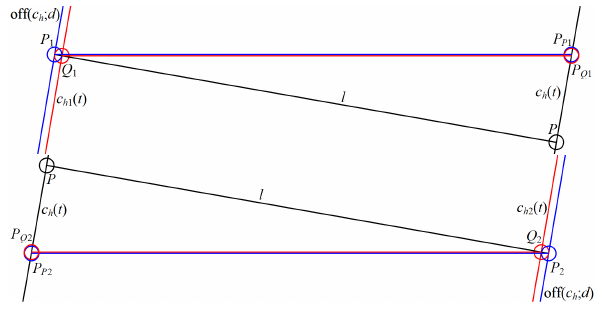
Figure 3: The arrangement of points and curves